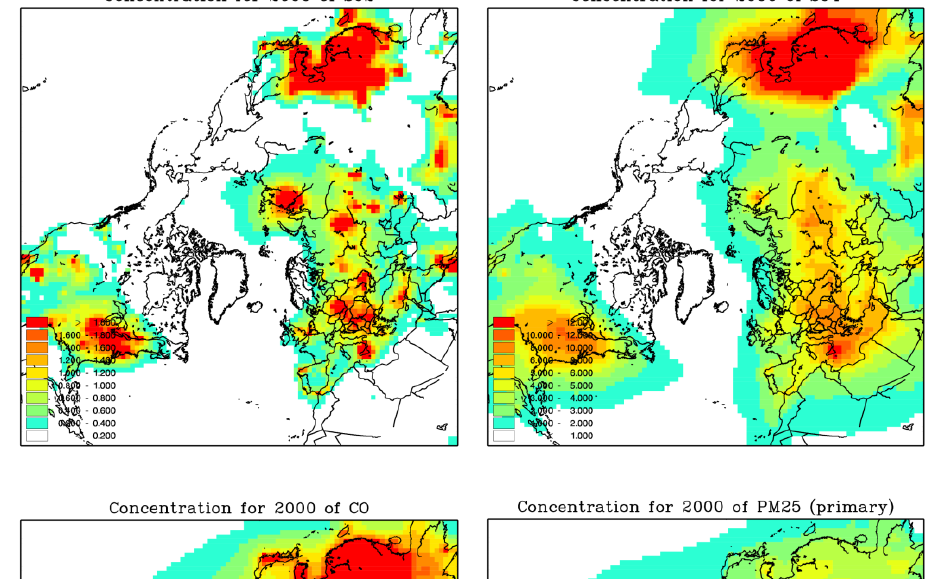
[µgm − 3 ] and O 3 [ppb]. Results are shown 3